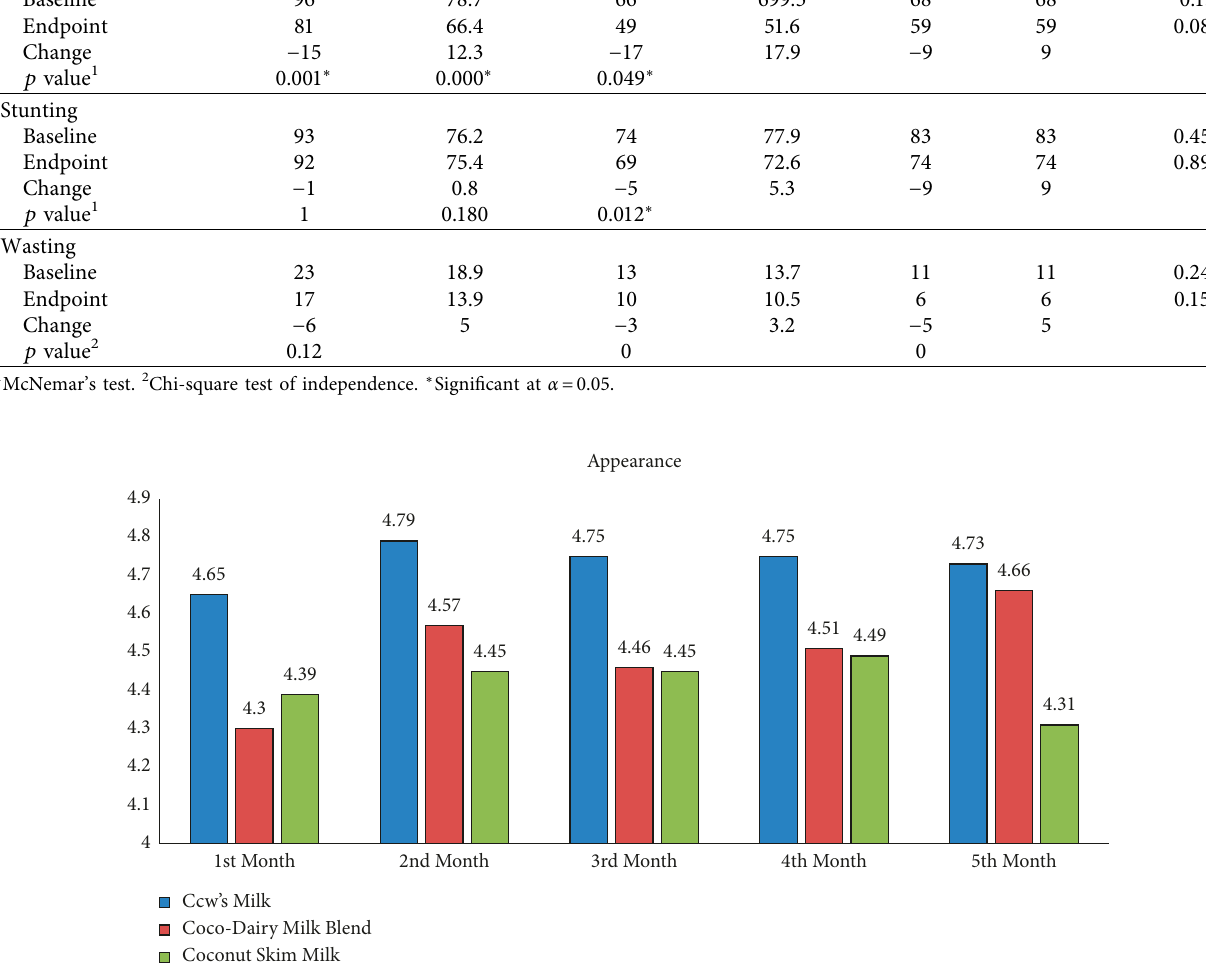
Figure 1: Average acceptability scores of milk products according to appearance by